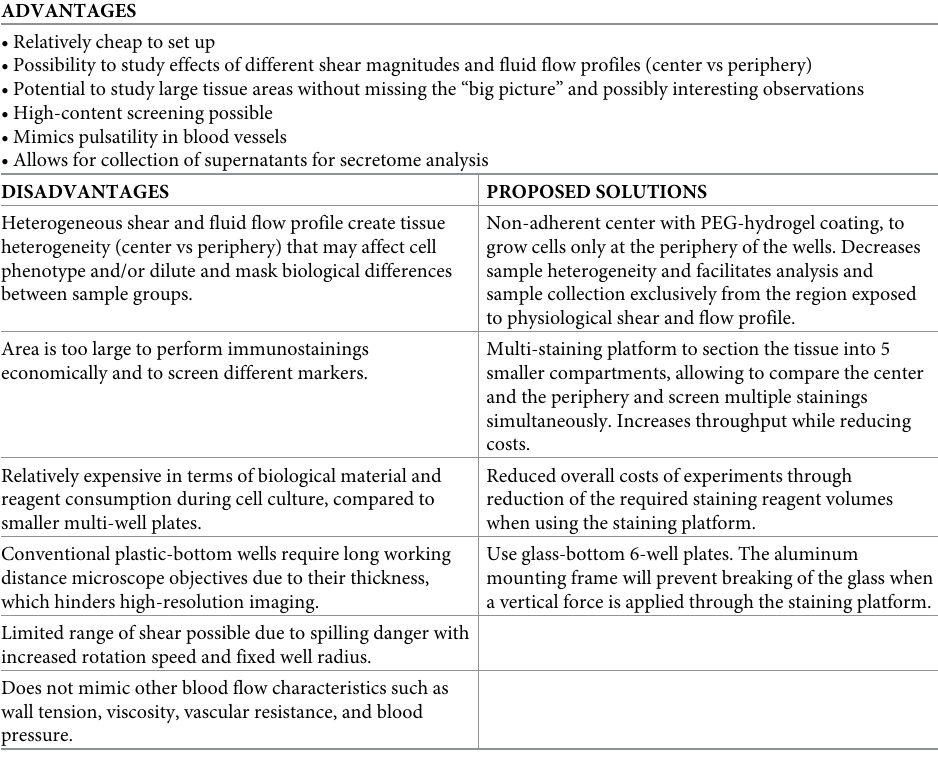
Table 1. Advantages and disadvantages of orbital shakers and how we addressed some of the associated